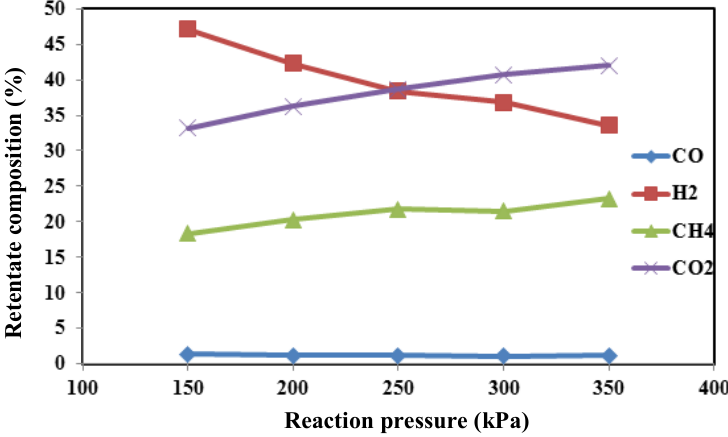
Figure 7. The composition of the gaseous products in retentate zone of the MR versus pressure.